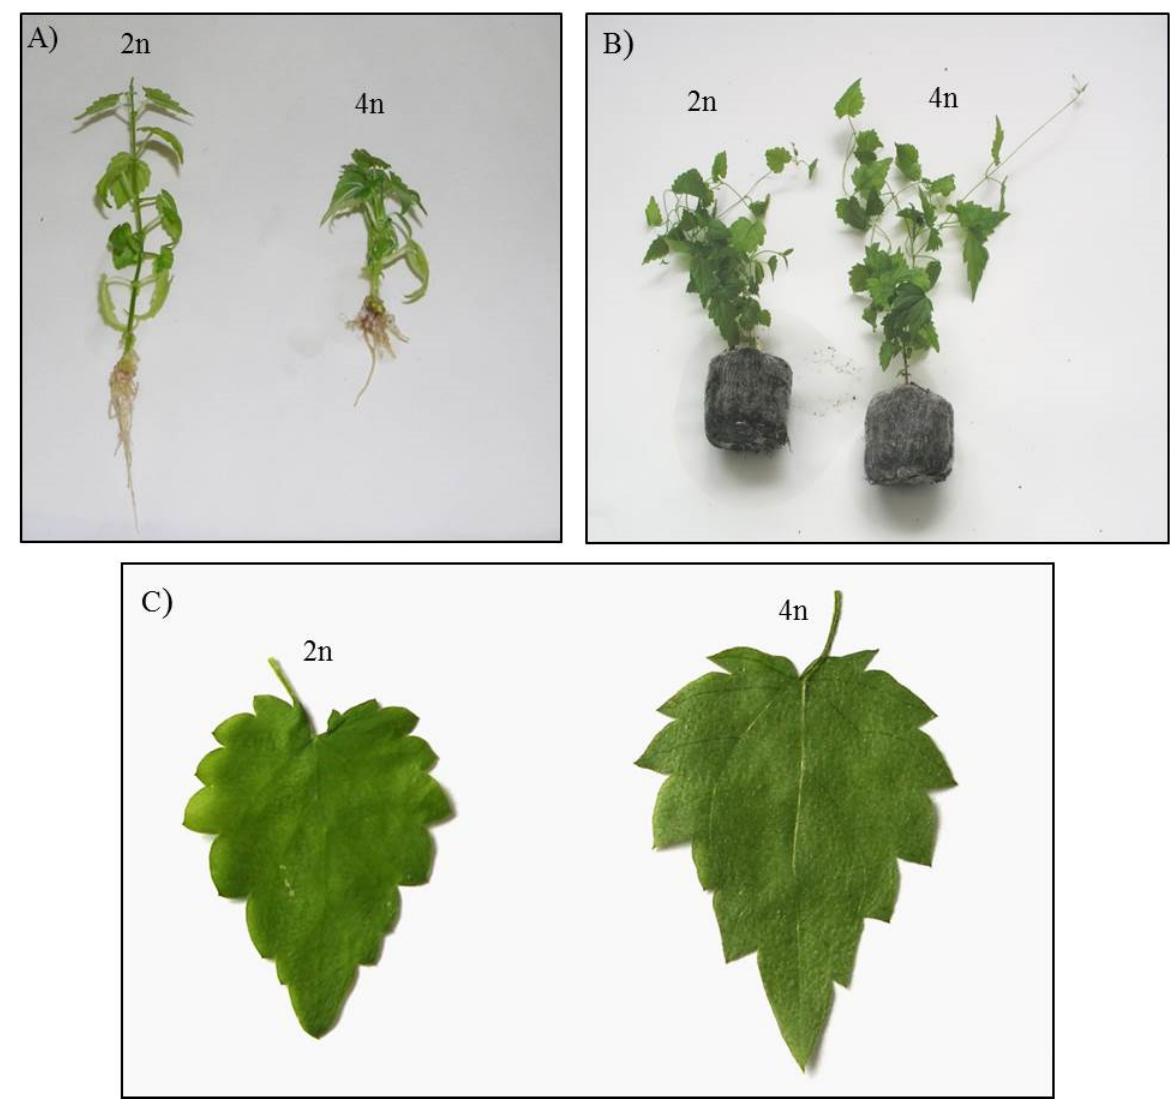
Fig. 3 Comparison of the morphology of control and tetraploid plantlets. ( A ) Rooting of polyploid (Clone 114, Sample 41) and control. ( B ) Converted plants (Clone 114, Sample 41) in the Jiffy pellets and control. ( C ) Variation in leaf shape of H. lupulus (Clone 114, Sample 41, and